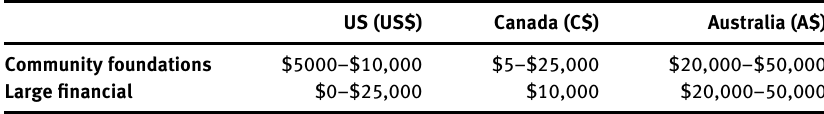
Table  : Minimum initial contributions across representative DAF